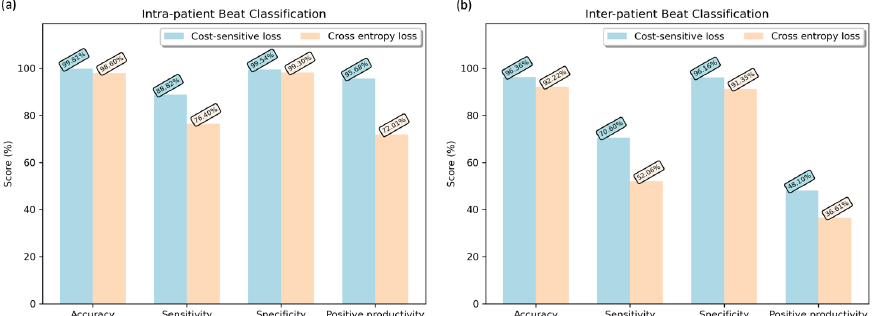
Figure 5. ( a ) Intra-patient beat classification performance comparison between cost-sensitive loss and conventional cross-entropy loss. ( b ) Inter-patient beat classification performance comparison between cost-sensitive loss and conventional cross-entropy